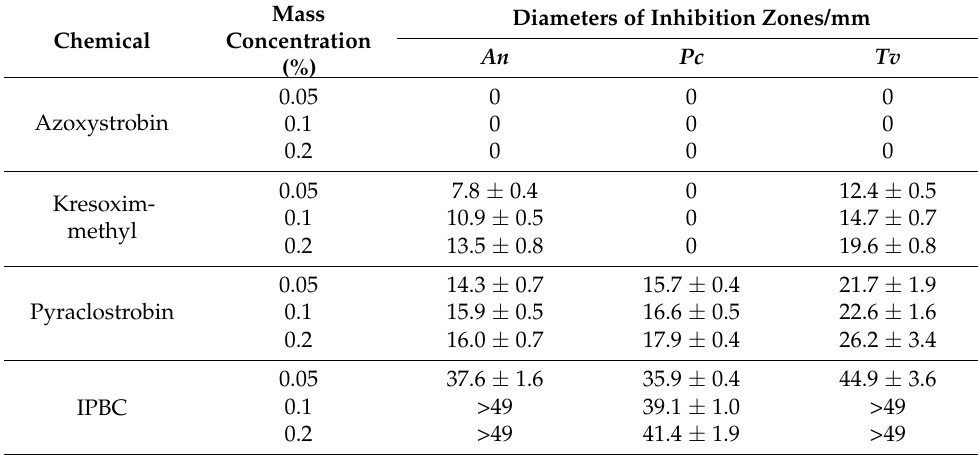
Table 3. The result of the inhibition zone tests for mold